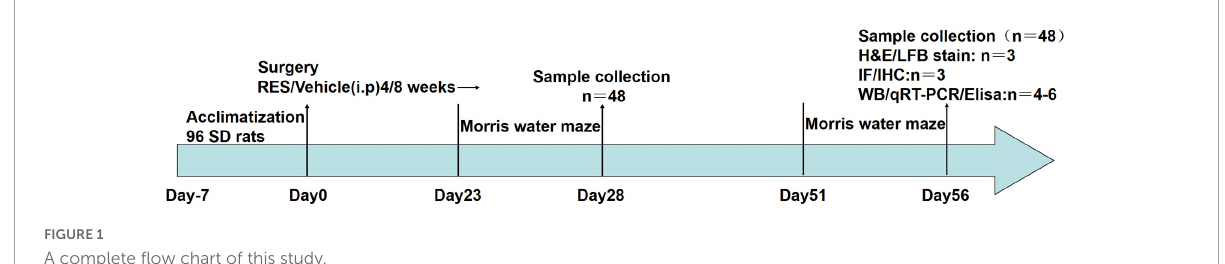
FIGURE1 A complete flow chart of this